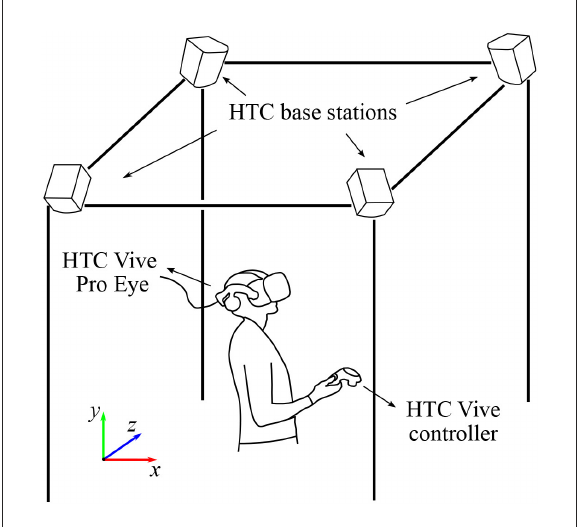
FIGURE1 Schematic representation of the experimental setup. The visual scenes were displayed using HTC Vive Pro Eye virtual reality headset. The position and rotation of the headset and the controller were tracked via four HTC base stations 2.0 paced in the four corners of the working space. The interaction with the environment was realized using the HTC controller held in the right hand of the participant. The colored axes represent Unity left-hand coordinate system. For details, see the main text.